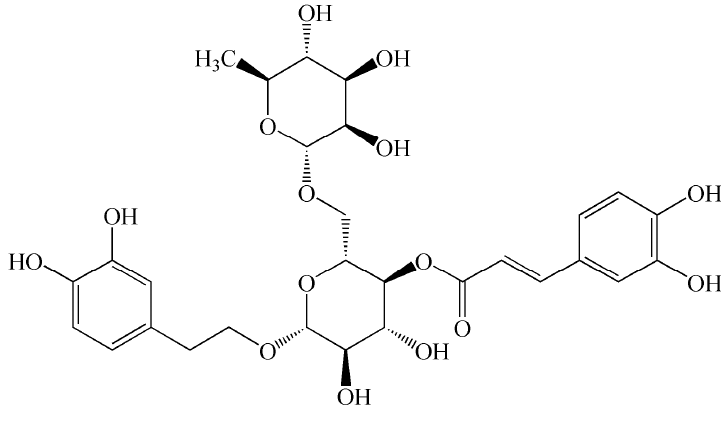
Figure 1. Chemical structural formula of forsythoside A.